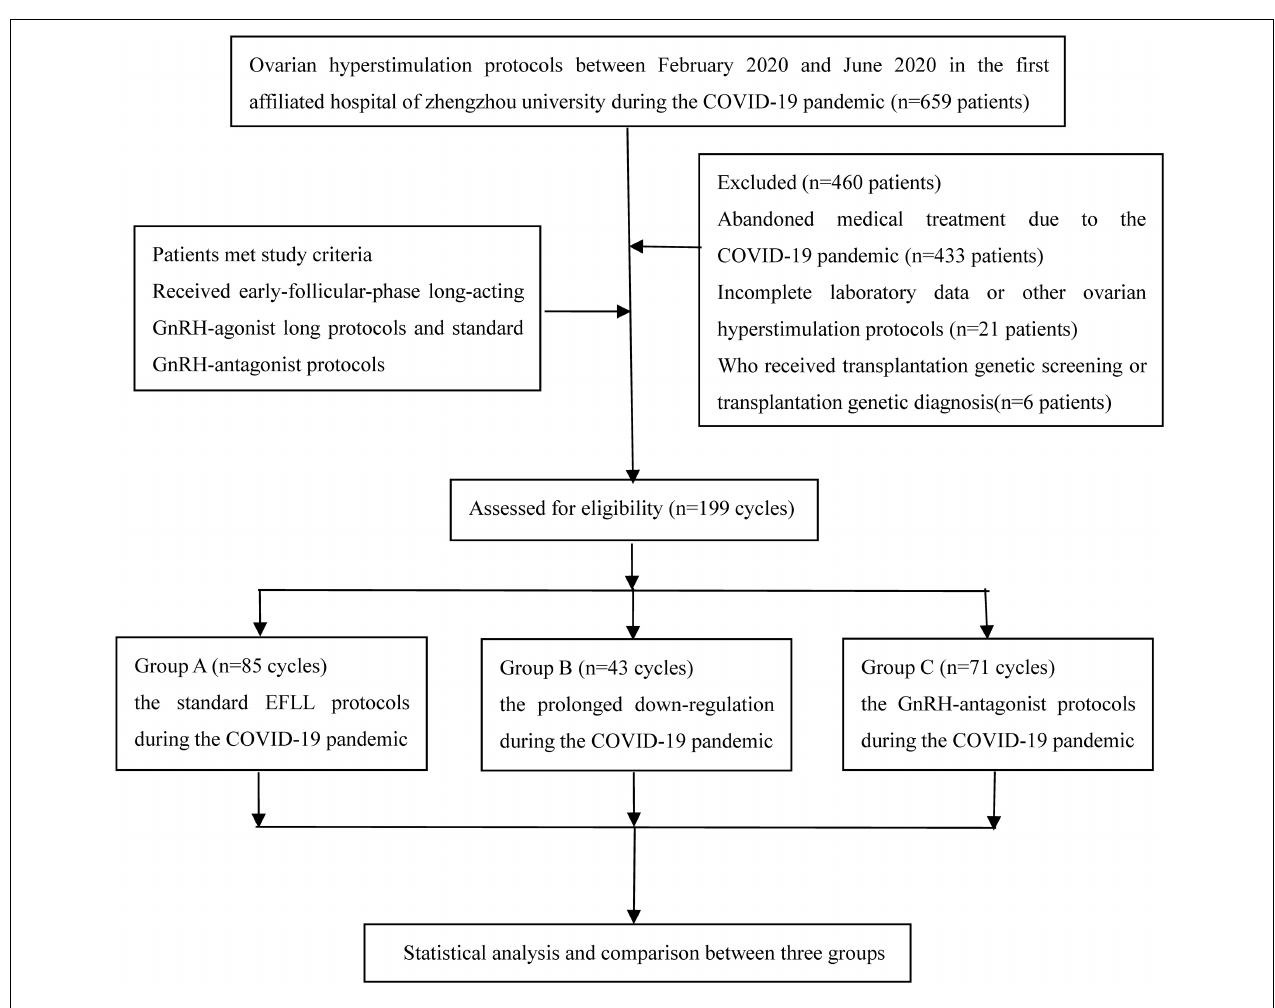
FIGURE 1 | The flow chart.